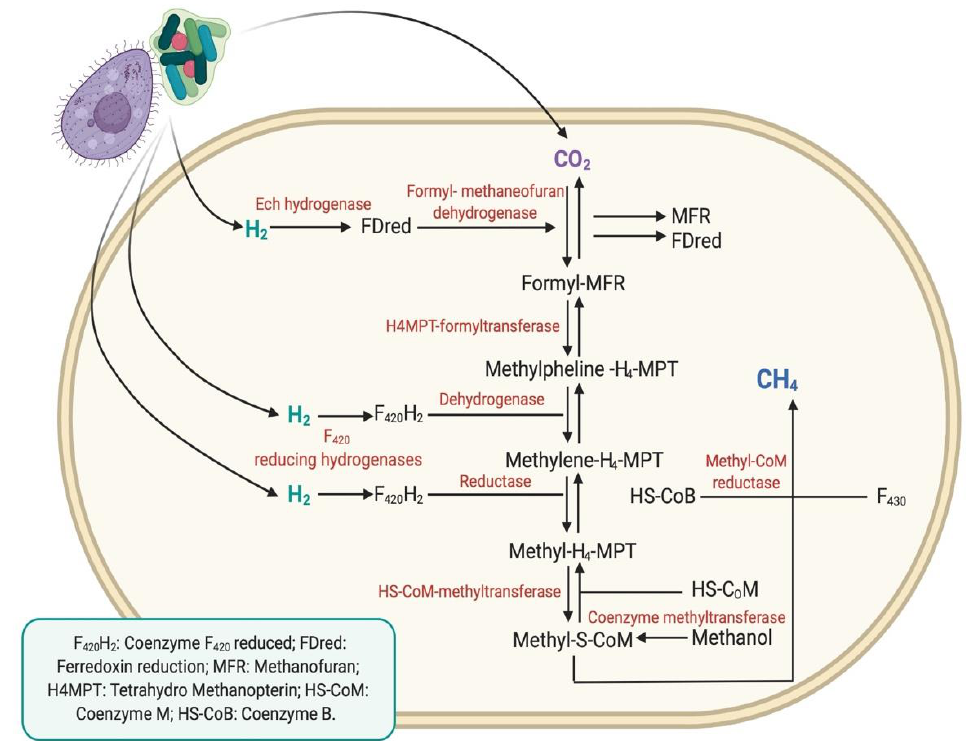
Figure 1. Hydrogenotrophic methanogenesis. Abbreviations: CH 4 : methane, CO 2 : carbon dioxide, H 2 : dihydrogen.